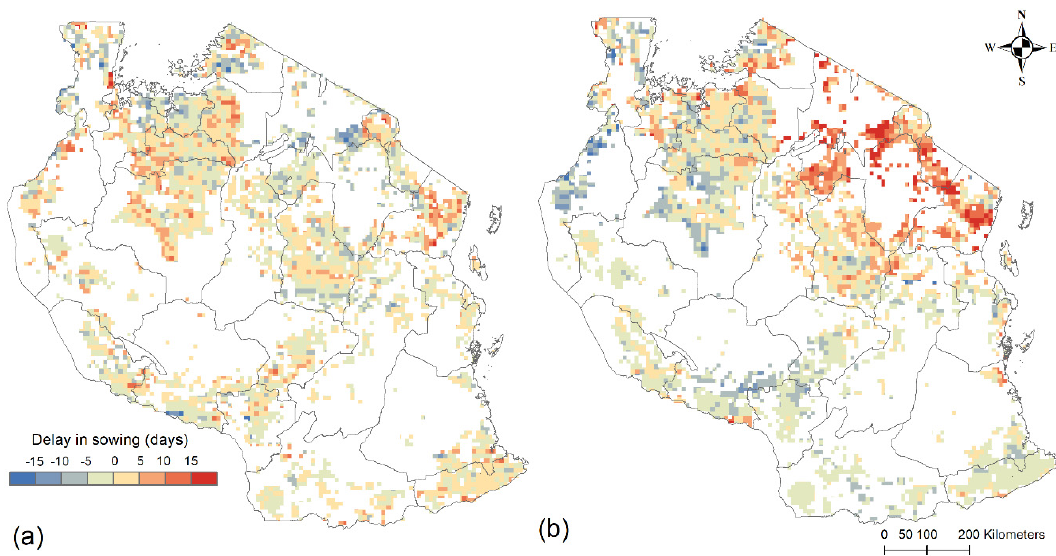
Figure 3. Spatial patterns of the changes in maize sowing date between decades: ( a ) changes from